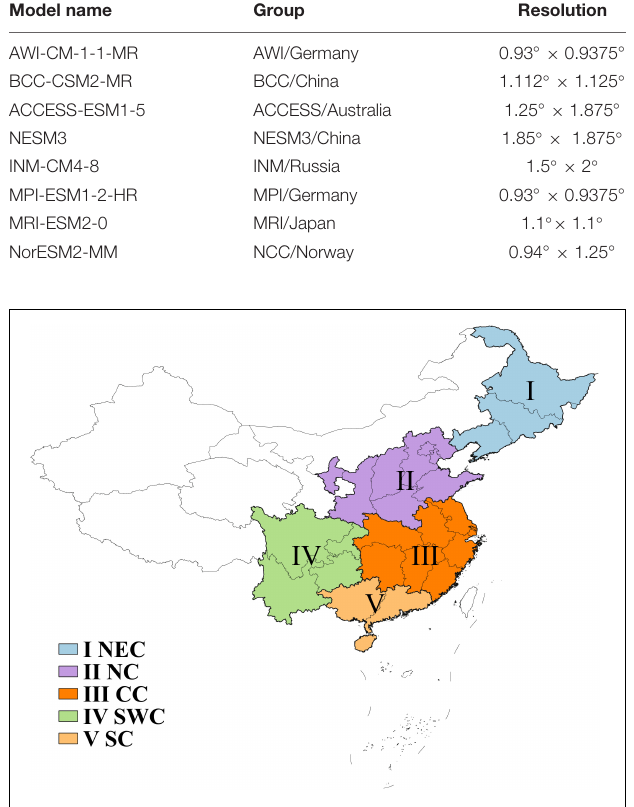
FIGURE 1 | China rice-growing regions. I, Northeast China rice-growing region (NEC); II, North China rice-growing region (NC); III, Central China rice-growing region (CC); IV, Southwest China rice-growing region (SWC); and V, South China rice-growing region